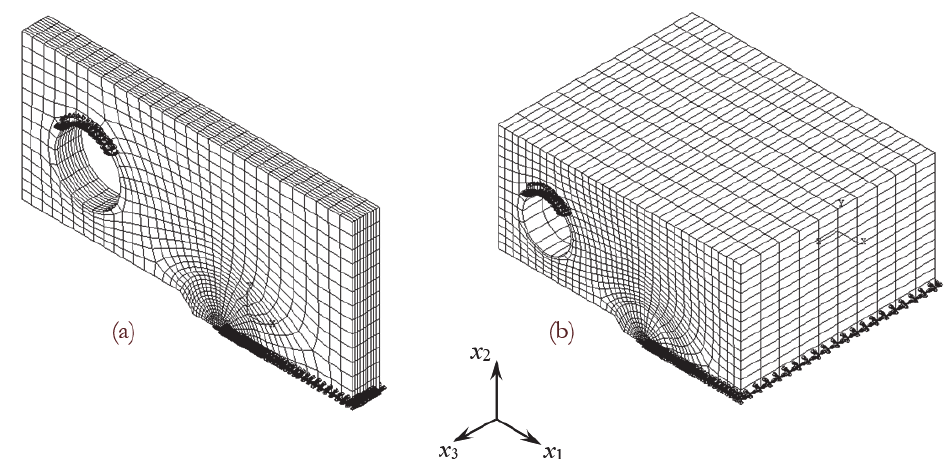
Figure 2: 3D CT Specimen mesh along with boundary conditions for a/W=0.50: a) B/W=0.1; b) B/W=1.